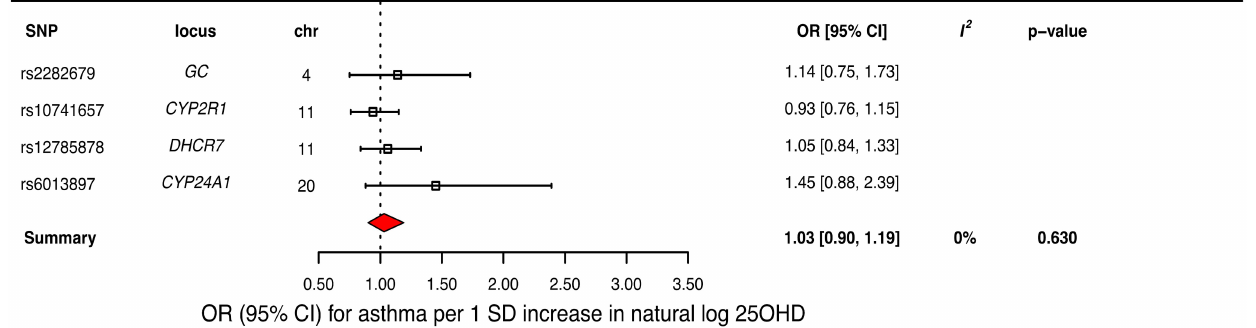
Fig 4. Mendelian randomization estimateof the association of 25-hydroxyvitamin D (25OHD) levels with risk of asthma. Estimates obtainedfrom using a fixed-effects model. 95% CI, 95% confidenceinterval; chr, chromosome, OR, odds ratio; SD, standarddeviation;SNP, single-nucleotide polymorphism.